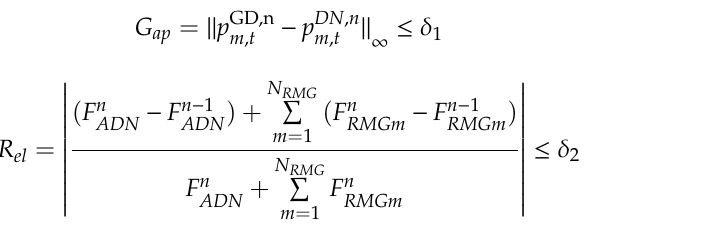
Figure 7. The 24-h load-demand profile for a household. Figure 8. The 24-h power load curve in the distribution network level and time-of-use (TOU) electricity price. 5.2. Simulation Results and Discussion In the RMGs level, the optimization problems of energy management are solved in parallel. The optimized result of energy resources scheduling for an arbitrarily specified RMG is shown in Figure 9.